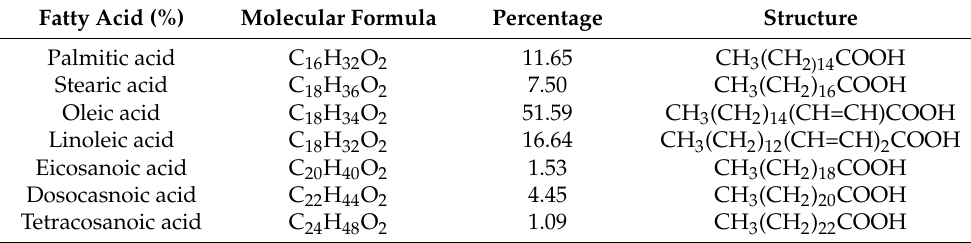
Table 3. Fatty acid composition of crude pongamia oil.